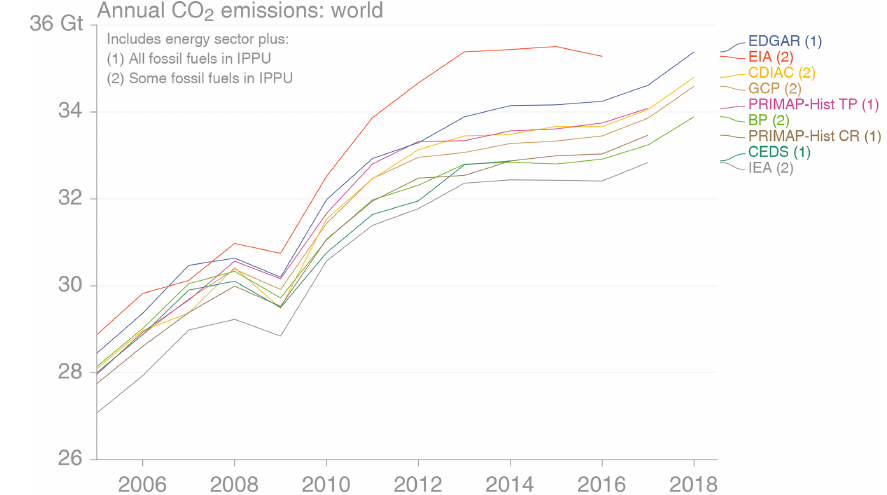
Figure 4. Annual global CO 2 emissions from various sources using similar system